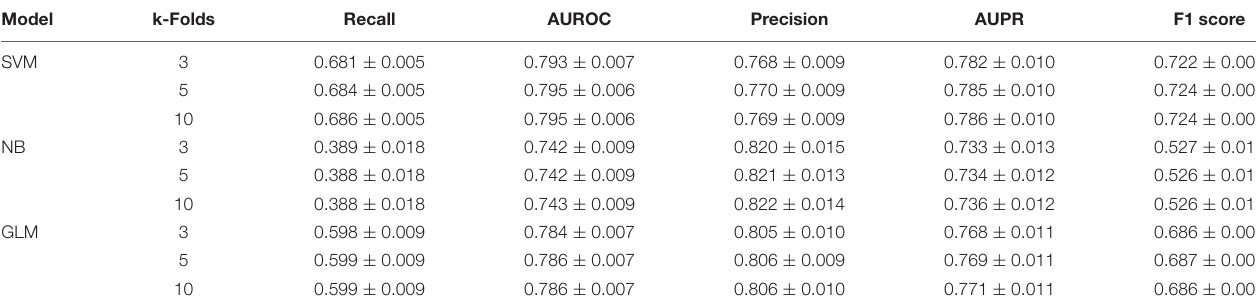
TABLE 1 | Performances of different models with a sample ratio of positive: negative = 1: 1. Model